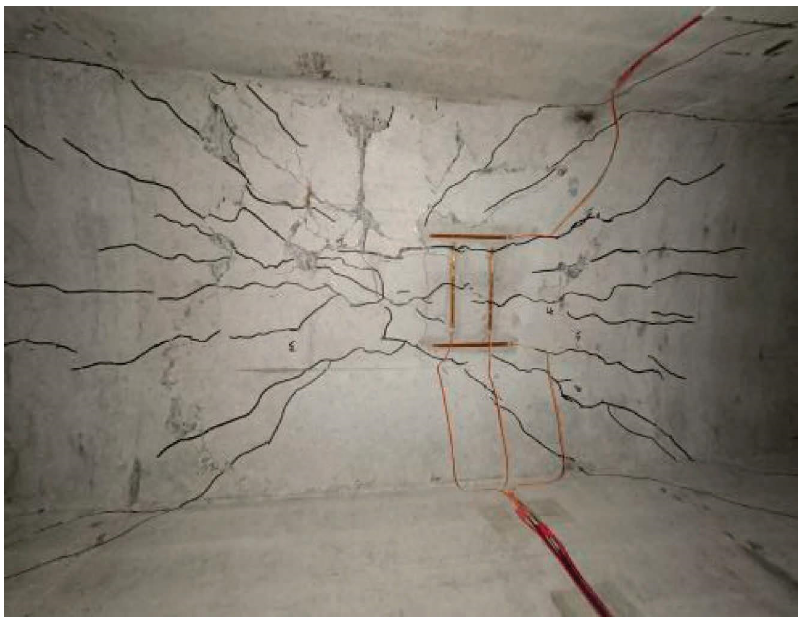
Figure 7: Te cracks in the bottom of the carriageway slab after